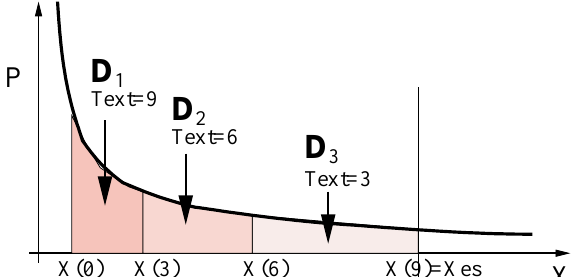
FIG. 4. (Color) Calculation in the normal coordinates frame of the emittance of the extracted beam. The points in the lightest domain D 3 are extracted after three iterations of the map M , and its area is the emittance extracted in that period. The points in the domains D 2 , D 1 are extracted after six and nine iterations, respectively.